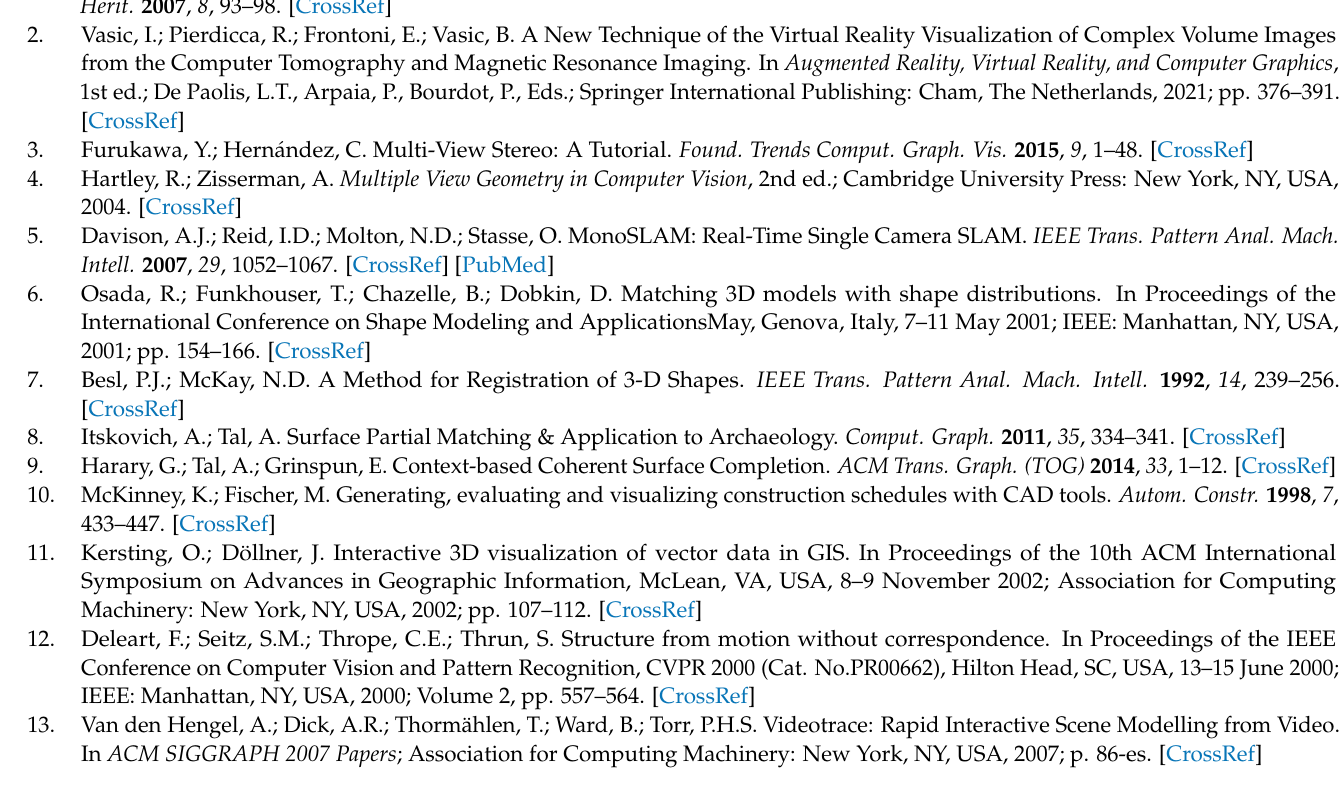
Figure A3. Illustration of quantization results using specified quantization levels and corresponding adaptive levels: ( a ) 𝑘 = 2 : (9 × 28 × 14) , ( b ) 𝑘 = 3 : (14 × 42 × 20) , ( c ) 𝑘 = 4 : (18 × 55 × 27) . The red, black and magenta markers in all illustrations denote the tolerance levels 1/2, 1/6, and 1/12, respectively.